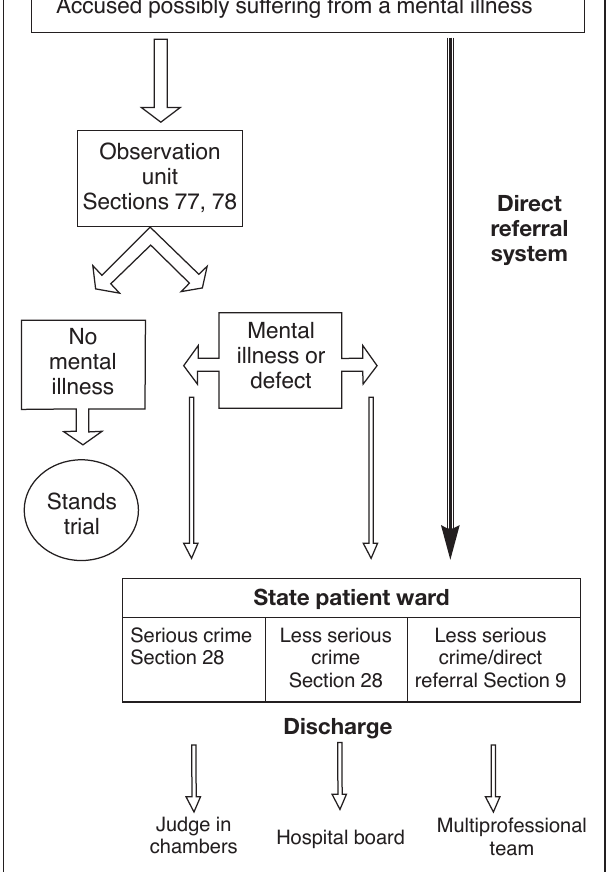
Fig. 1. Schematic representation of direct referral